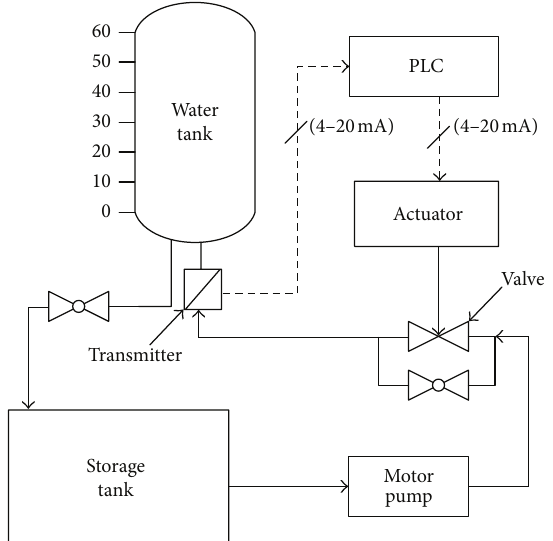
Figure 1: Schematic diagram of the liquid level control system.